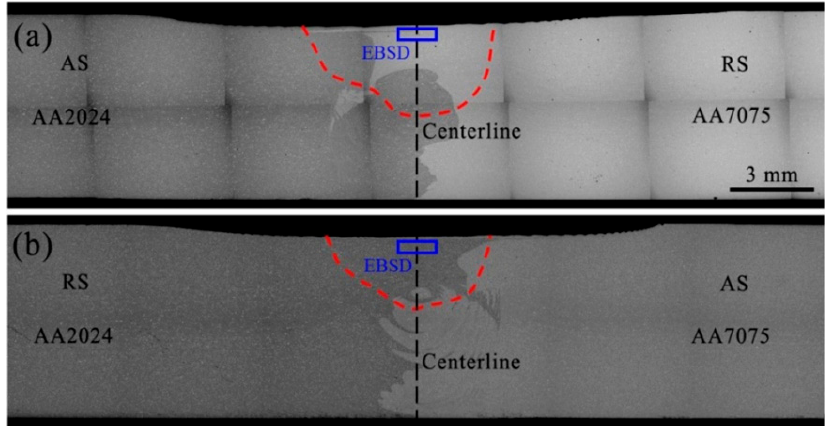
Figure 5. Cross-sectional SEM macrostructure of the AA2024-AA77075 joints: ( a ) AS: AA2024 and ( b ) AS: AA7075 , reproduced from [71], with permission from Elsevier, 2019.